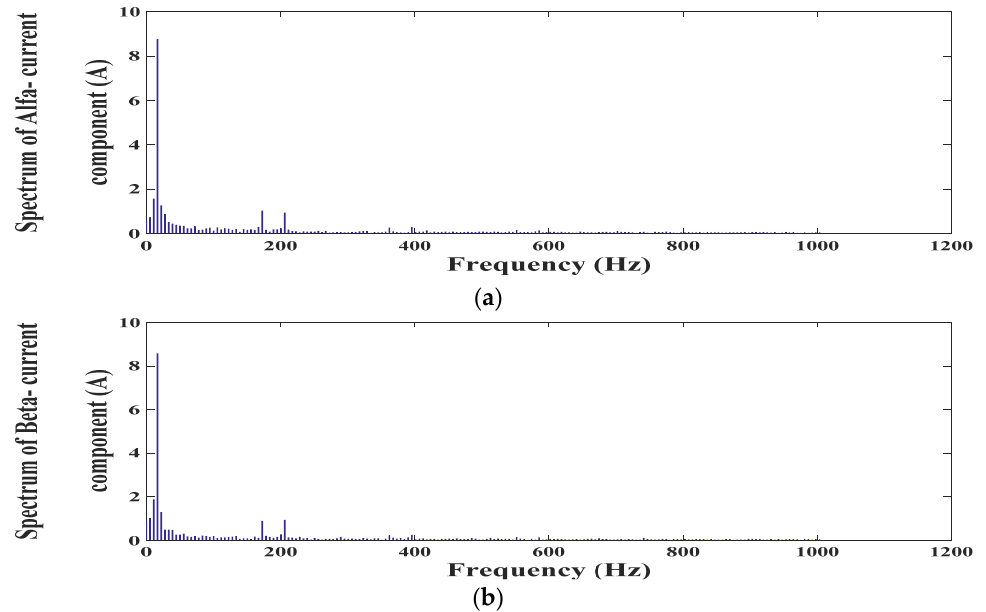
Figure 20. ( a ). FFT spectrum of α -component of stator current under PTC, ( b ). FFT spectrum of β -component of stator current under PTC.